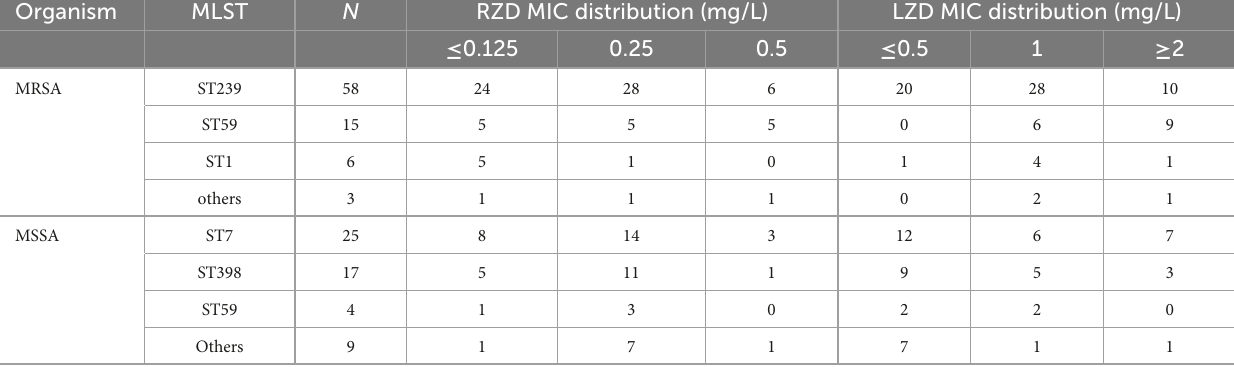
TABLE 2 Relationship between STs and the MIC value of radezolid or linezolid in S. aureus. Organism MLST N RZD MIC distribution (mg/L) LZD MIC distribution (mg/L) ≤